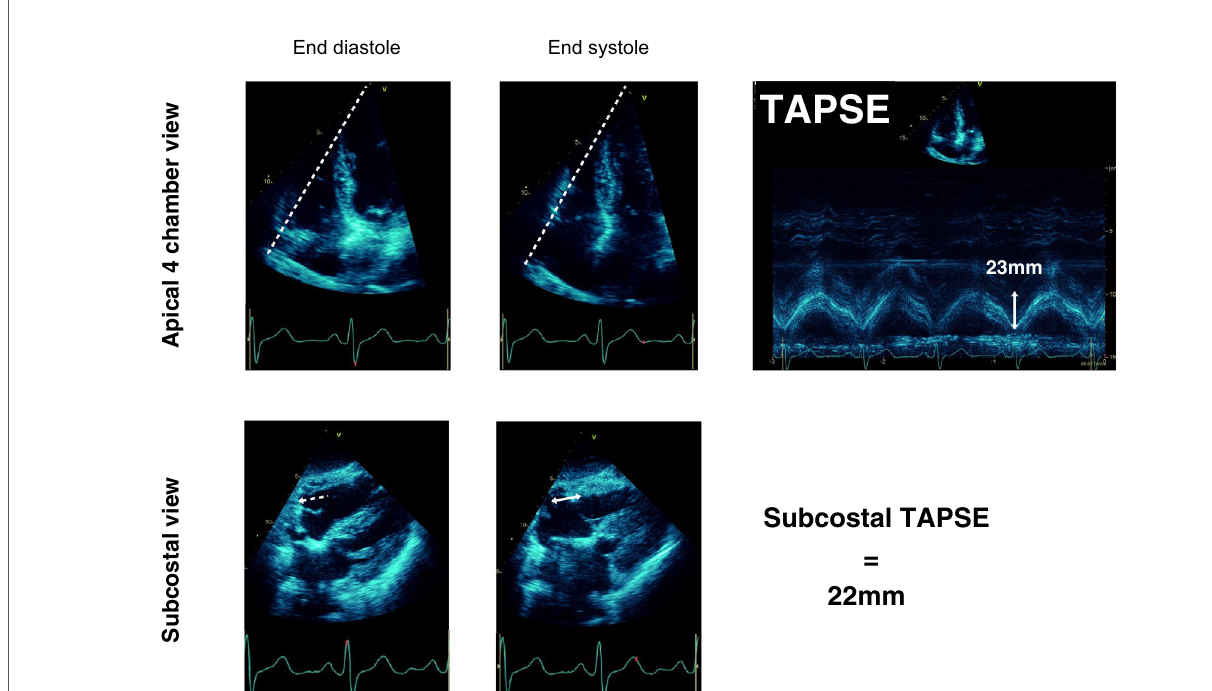
Fig. 1 TAPSE measurement. a A4C TAPSE: standard method from the A4C window using M-mode. b Subcostal TAPSE: measured from subcostal window using B-mode imaging and marker